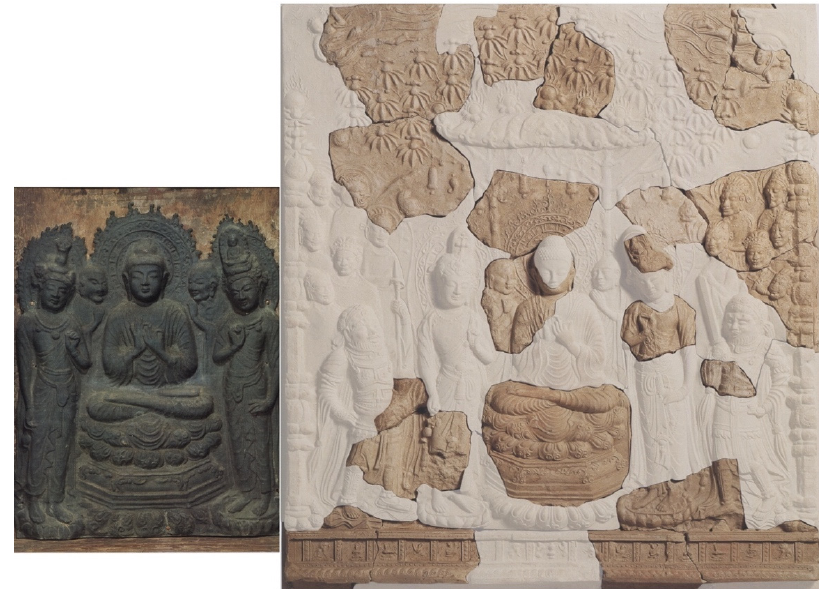
Figure 16. ( left ) Amitabha triad and two monks, 39.0 × 32.5 cm, seventh century; Tokyo National Museum. ( right ) Clay Buddha, Niko temple site, Nara, 50 × 50 cm, Kashihara kokogaku kennkyusho. [left Source: (NRDK 2001, plate 34), right Source: (Nara National Museum 2015, plate 93)]. In general, there are two opposing views on the dating of the Hwa ŏ msa bronze Buddha mold.